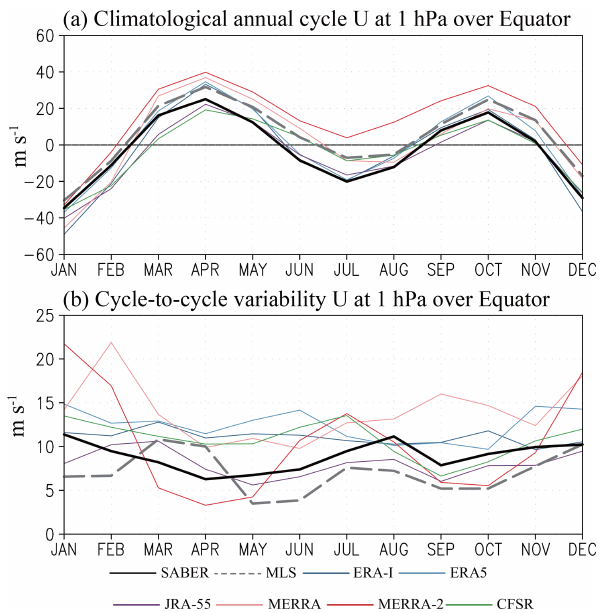
Figure 7. (a) Climatological mean annual cycle of zonal mean zonal wind over the Equator at 1hPa for SABER, MLS, and each reanal- ysis; (b) cycle-to-cycle variability of equatorial zonal mean zonal wind calculated as the interannual standard deviation in each calen- dar month. Climatology and standard deviation are calculated from 1980 to 2010 in the reanalyses, from 2002 to 2016 in SABER, and from 2005 to 2016 in